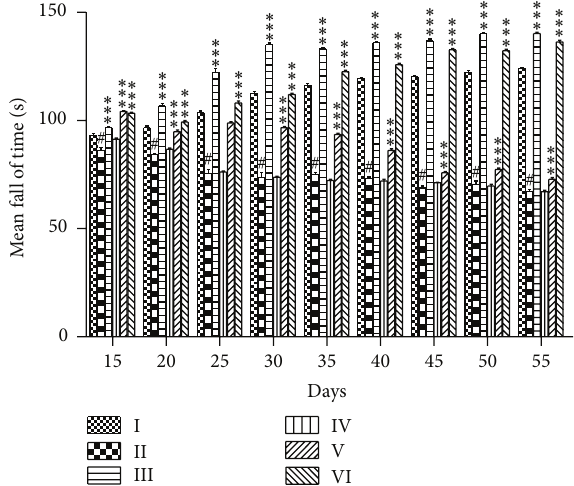
Figure 2: The effects of PEFRE on 6-OHDA induced Parkinson’s disease in the Locomotor activity. Group I: Vehicle control group; Group II: 6-OHDA treated group; Group III: Levodopa + 6-OHDA treated group; Group IV: PEFRE (100mg/kg) + 6-OHDA treated group; Group V: PEFRE (200mg/kg) + 6-OHDA treated group; Group VI: PEFRE (400mg/kg) + 6-OHDA treated group. ∗∗∗ 𝑝 < 0.001 as compared to 6-OHDA treated negative control group (Group II). # 𝑝 < 0.001 in 6-OHDA treated negative control group (Group II) compared to vehicle treated control group (Group I).